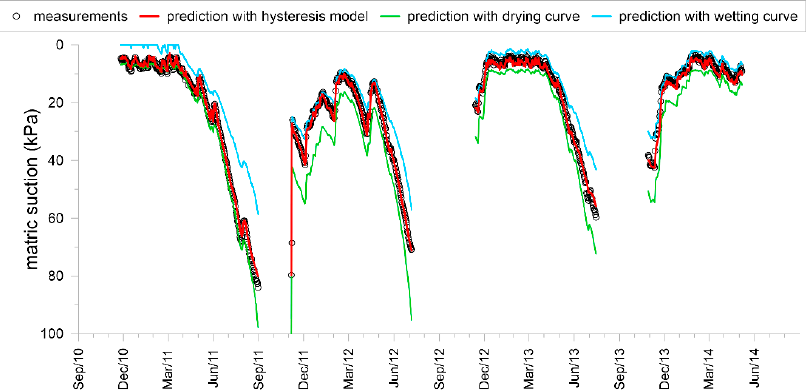
Figure 10. Evolution of matric suction measurements and theoretical predictions derived from water content measurements by using the LP model, main drying curve, and main wetting curve over 2010–2014.